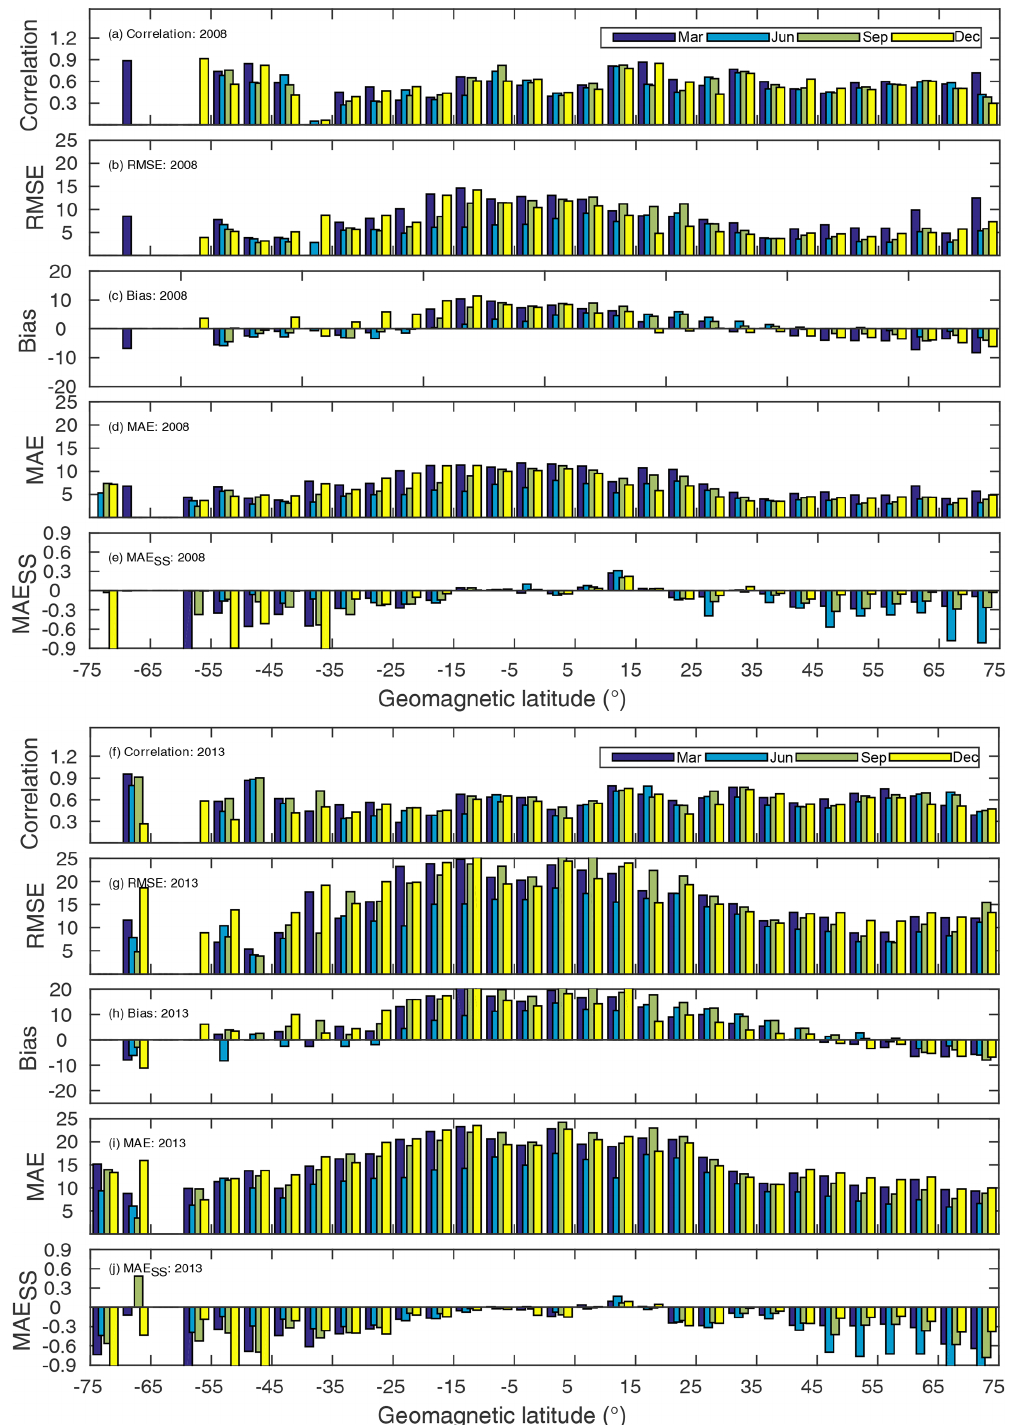
Figure 2. The correlation, RMSE, bias, MAE, and MAE SS determined from the comparison of TECs from IRI-2016 and the GPS receiver stations shown in Fig. 1 for 2008 (a–e) and 2013 (f–j) . The statistical metrics are evaluated for the calendar months indicated by the